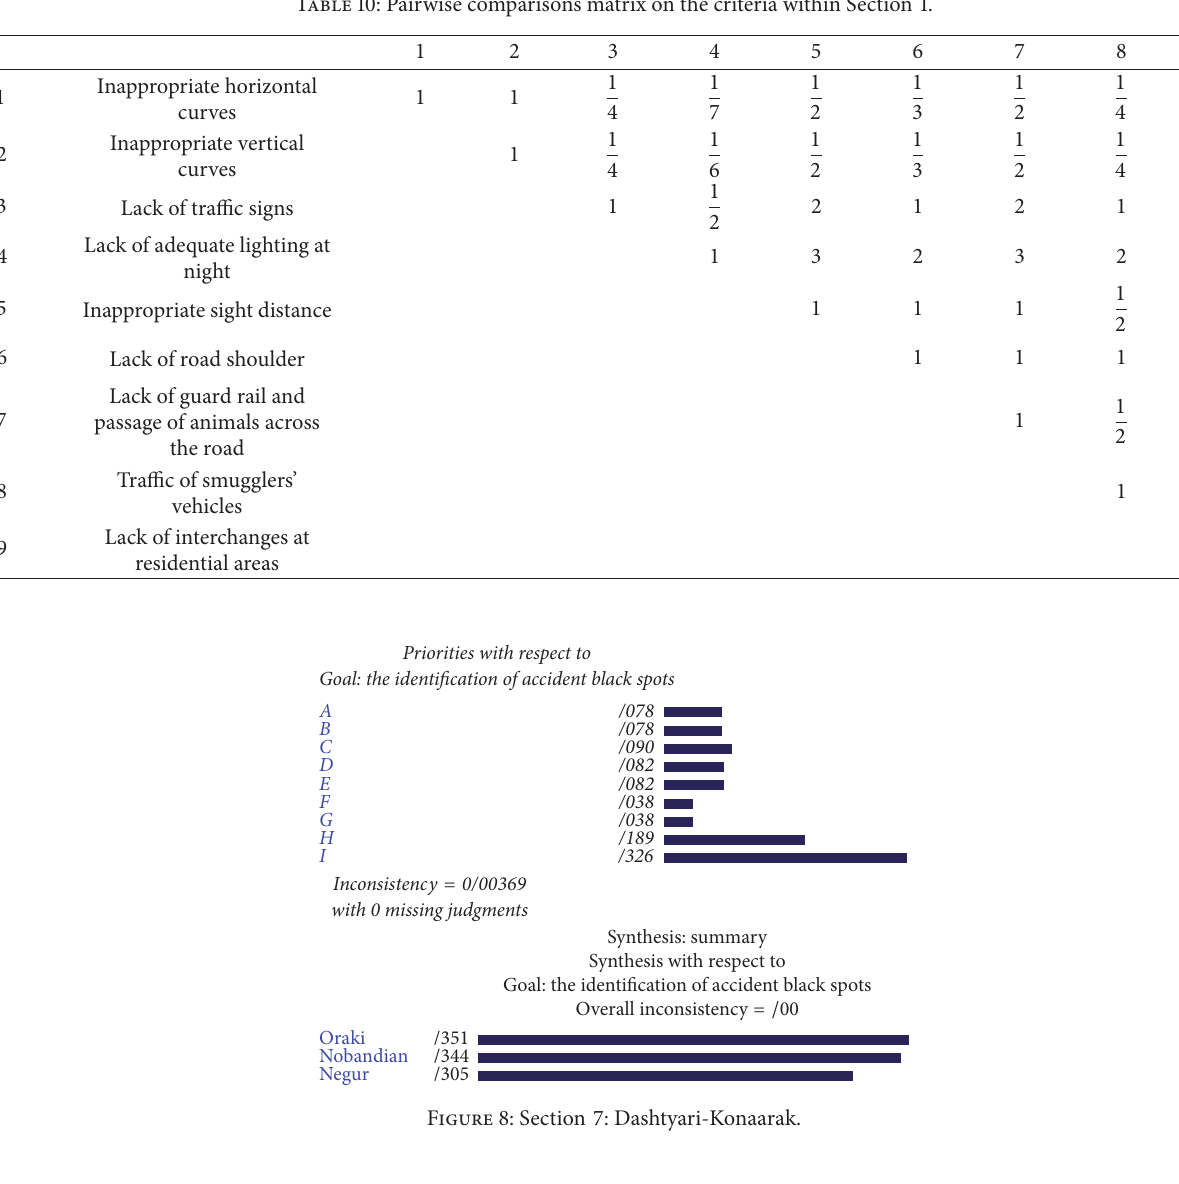
Table 10: Pairwise comparisons matrix on the criteria within Section 1.